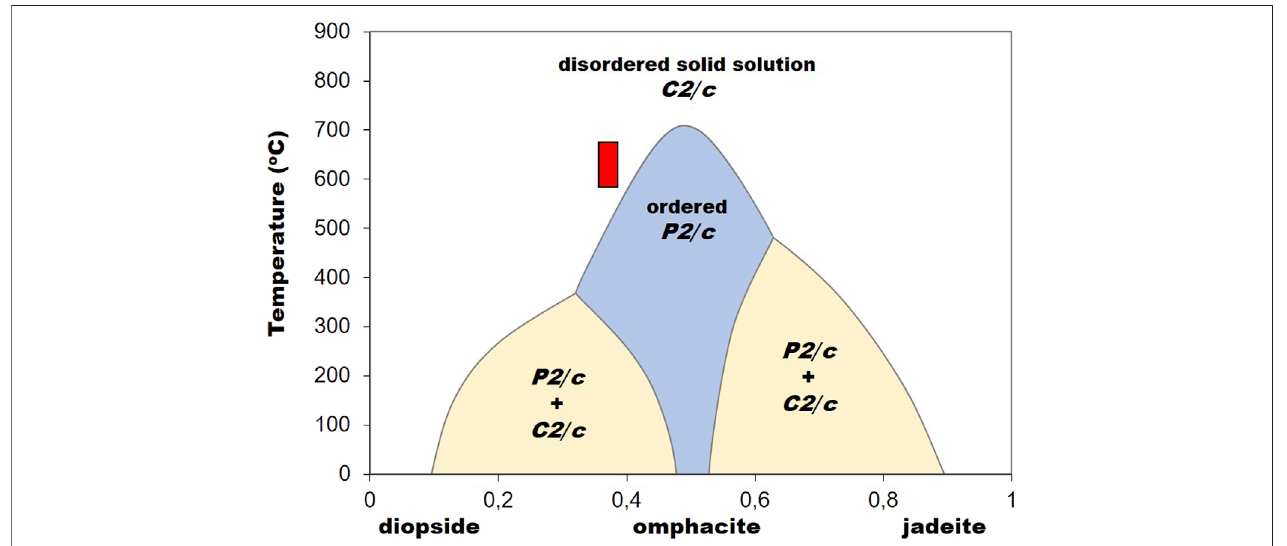
FIGURE 9 | Phase diagram for the jadeite-diopside system (adapted and modi fi ed after Carpenter, 1981). The red box indicates jadeite content in omphacite and calculated equilibrium temperatures according to Holland and Powell (2003).